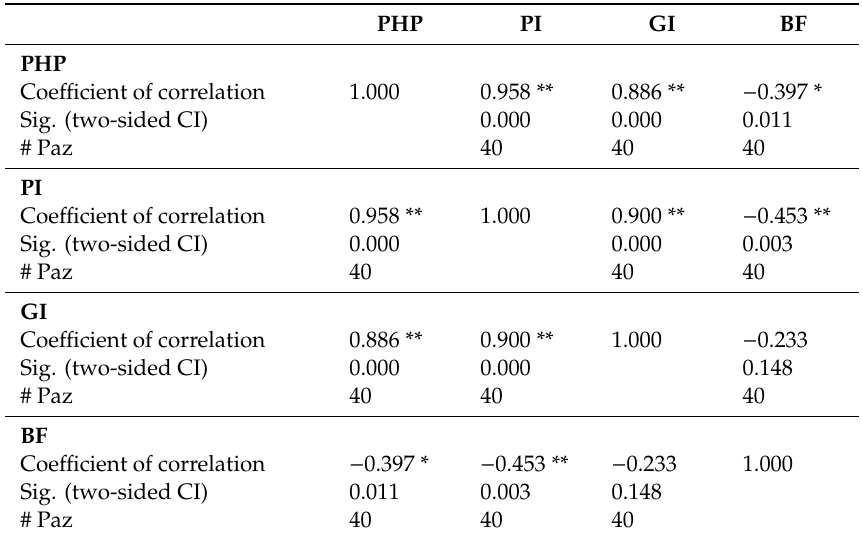
Table 3. Spearman’s ρ test between all oral indices( Toothbrushing frequency (BF), Gingival index (GI, number of patients (Paz)).